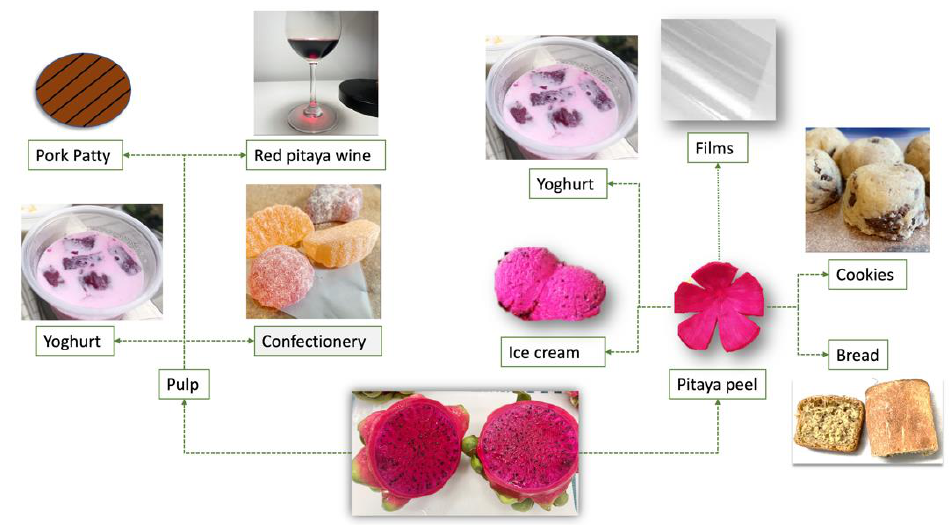
Figure 2. Utilisation of red pitaya in food products.